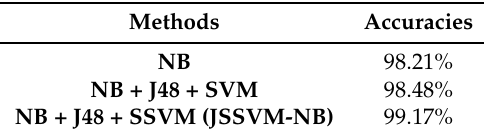
Table 7. The corresponding threshold data.